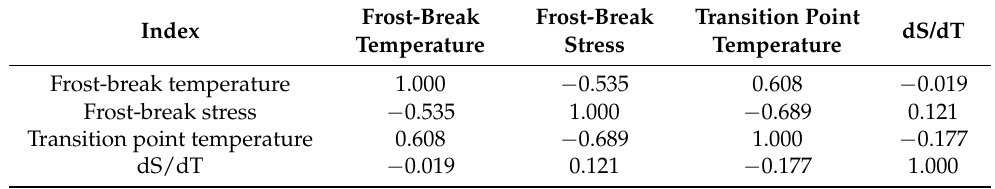
Table 6. Correlation coefficient matrix.